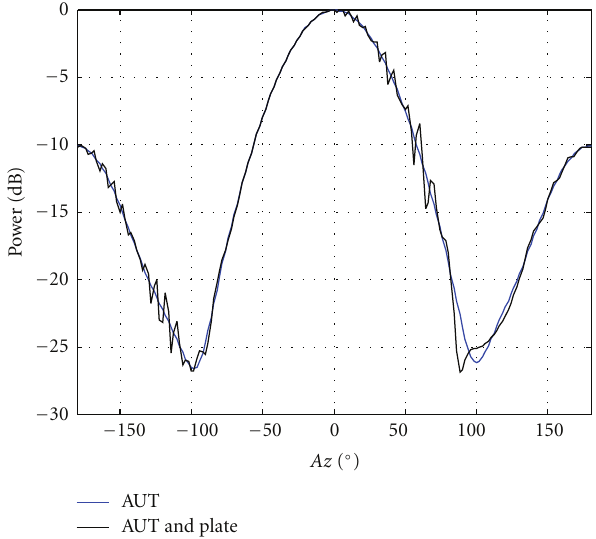
Figure 4: Far-field amplitude pattern of OEWG with and without plate. AUT o ff set =